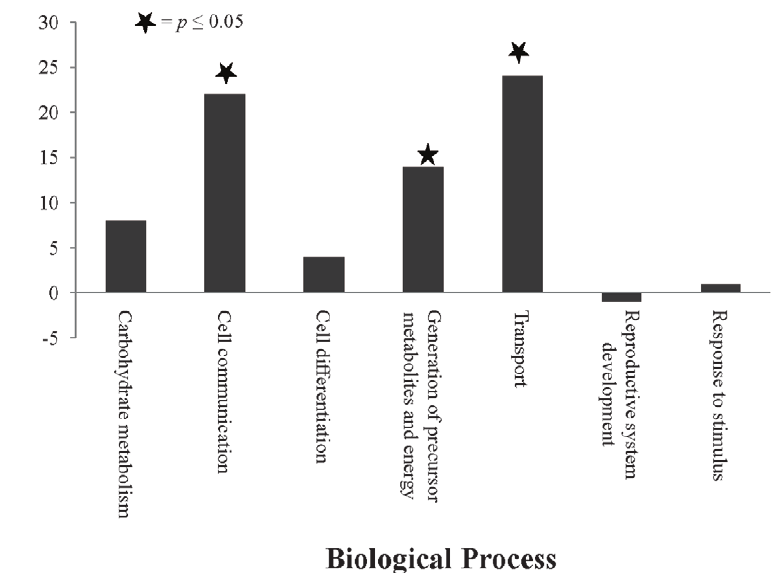
Figure 4. Overall effects in GO Slims of differentially expressed proteins of germinal vesicle (GV) oocyte and cumulus cells. Biological process GO annotations of all differentially-expressed proteins between GV oocyte and cumulus cells were used to generate GO Slims. For each GO Slim the difference in the numbers of proteins with higher expression and the number of proteins with lower expression in cumulus cells (relative to GV oocyte) was calculated to estimate the net regulatory effect.